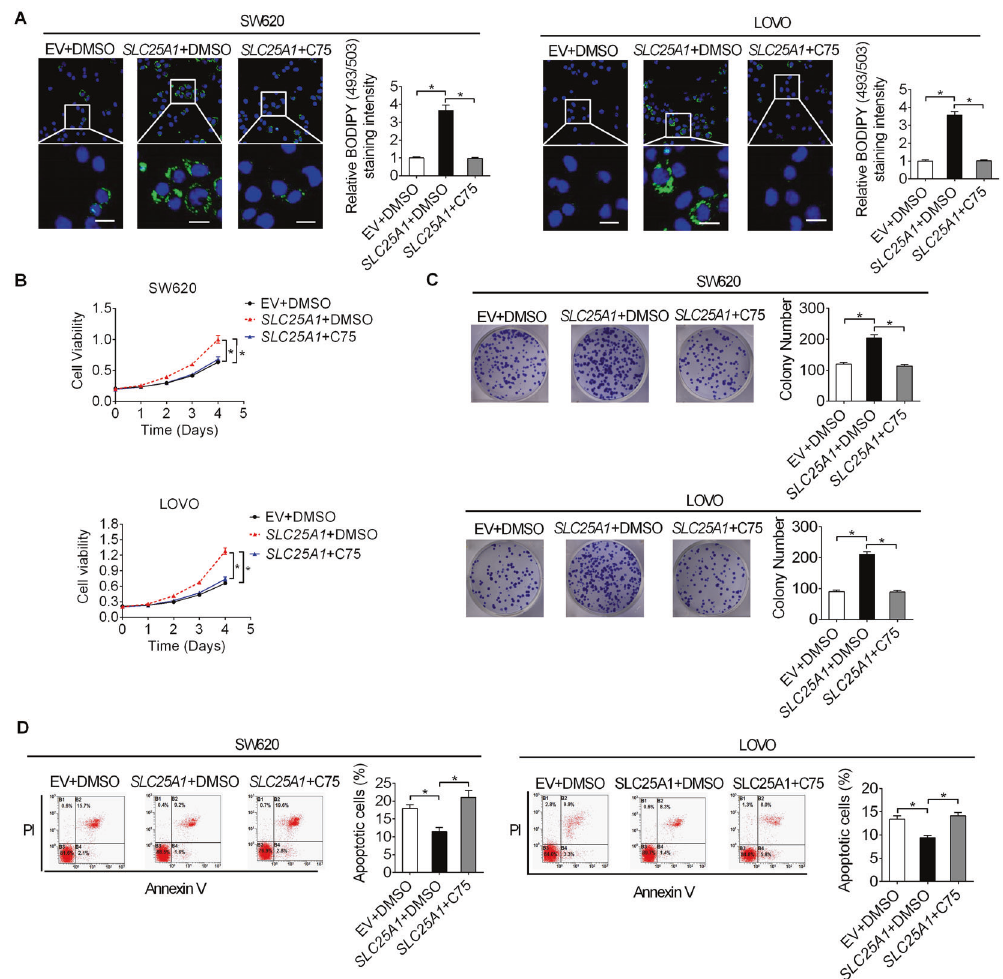
Fig. 5 SLC25A1 promoted CRC growth by increasing fatty acid synthesis. A Intracellular contents of neutral lipids were stained with the fl uorescence lipophilic dye BODIPY 493/503 in CRC cells treated with C75. Scale bars, 10 μ m. B Cell proliferation was determined by MTS assay in CRC cells treated with C75. C Colony formation assay in CRC cells treated with C75. D Flow cytometry analysis for cell anostosis in CRC cells treated with